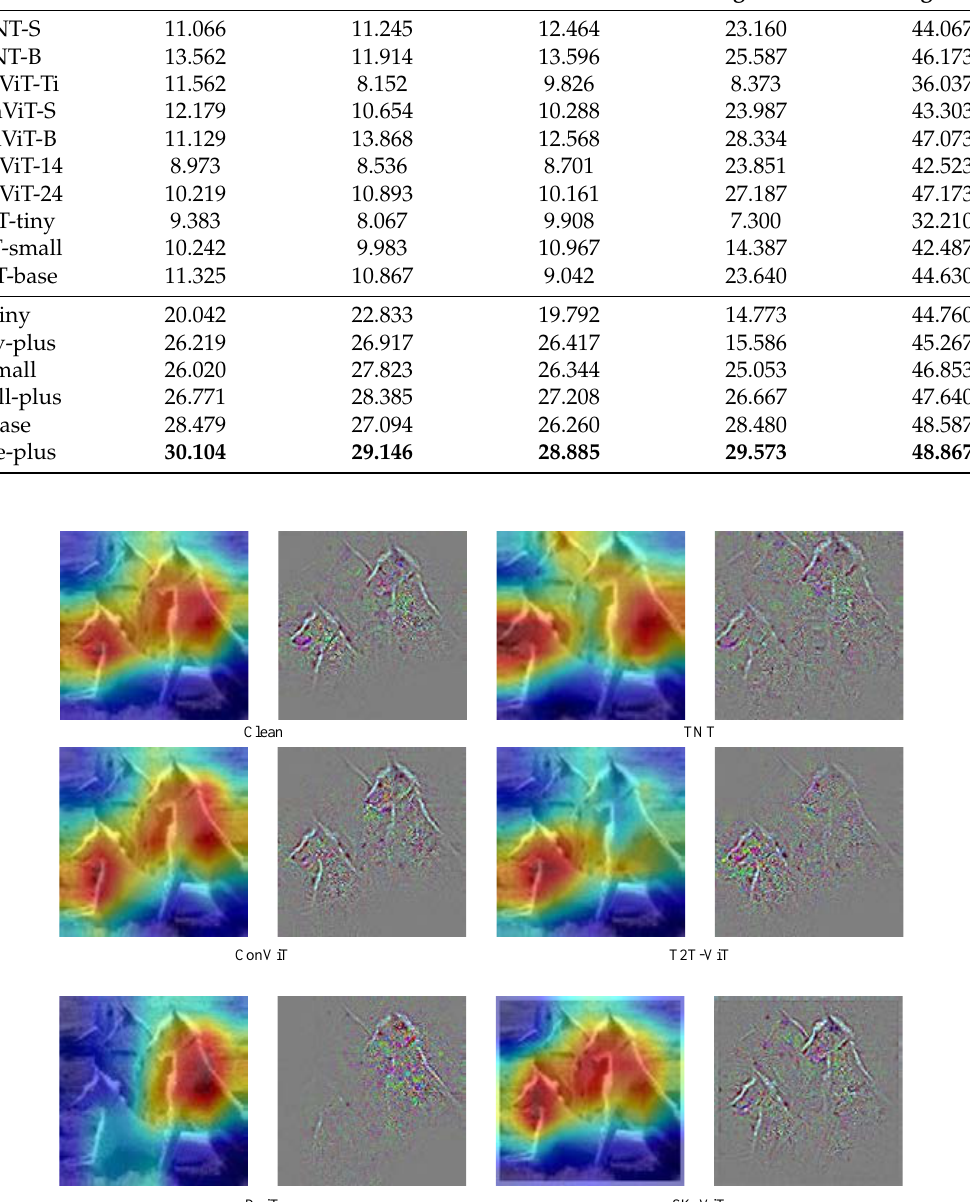
Figure 4. Comparison of different Transformer structures with SK-ViT. As can be seen in Figure 4, the feature maps extracted by SK-ViT are most similar to those of Clean compared to the other four structures, which indicates that the SK module can capture minute features better and is able to remap the adversarial examples back to the clean example space. It also further validates the results in Table